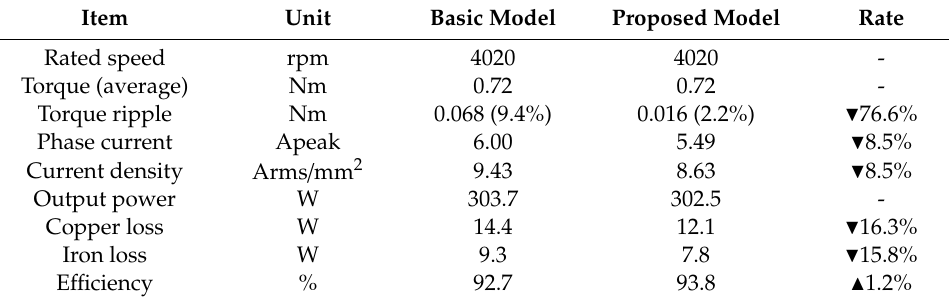
Table 8. Comparison of finite element method (FEM) analysis results.